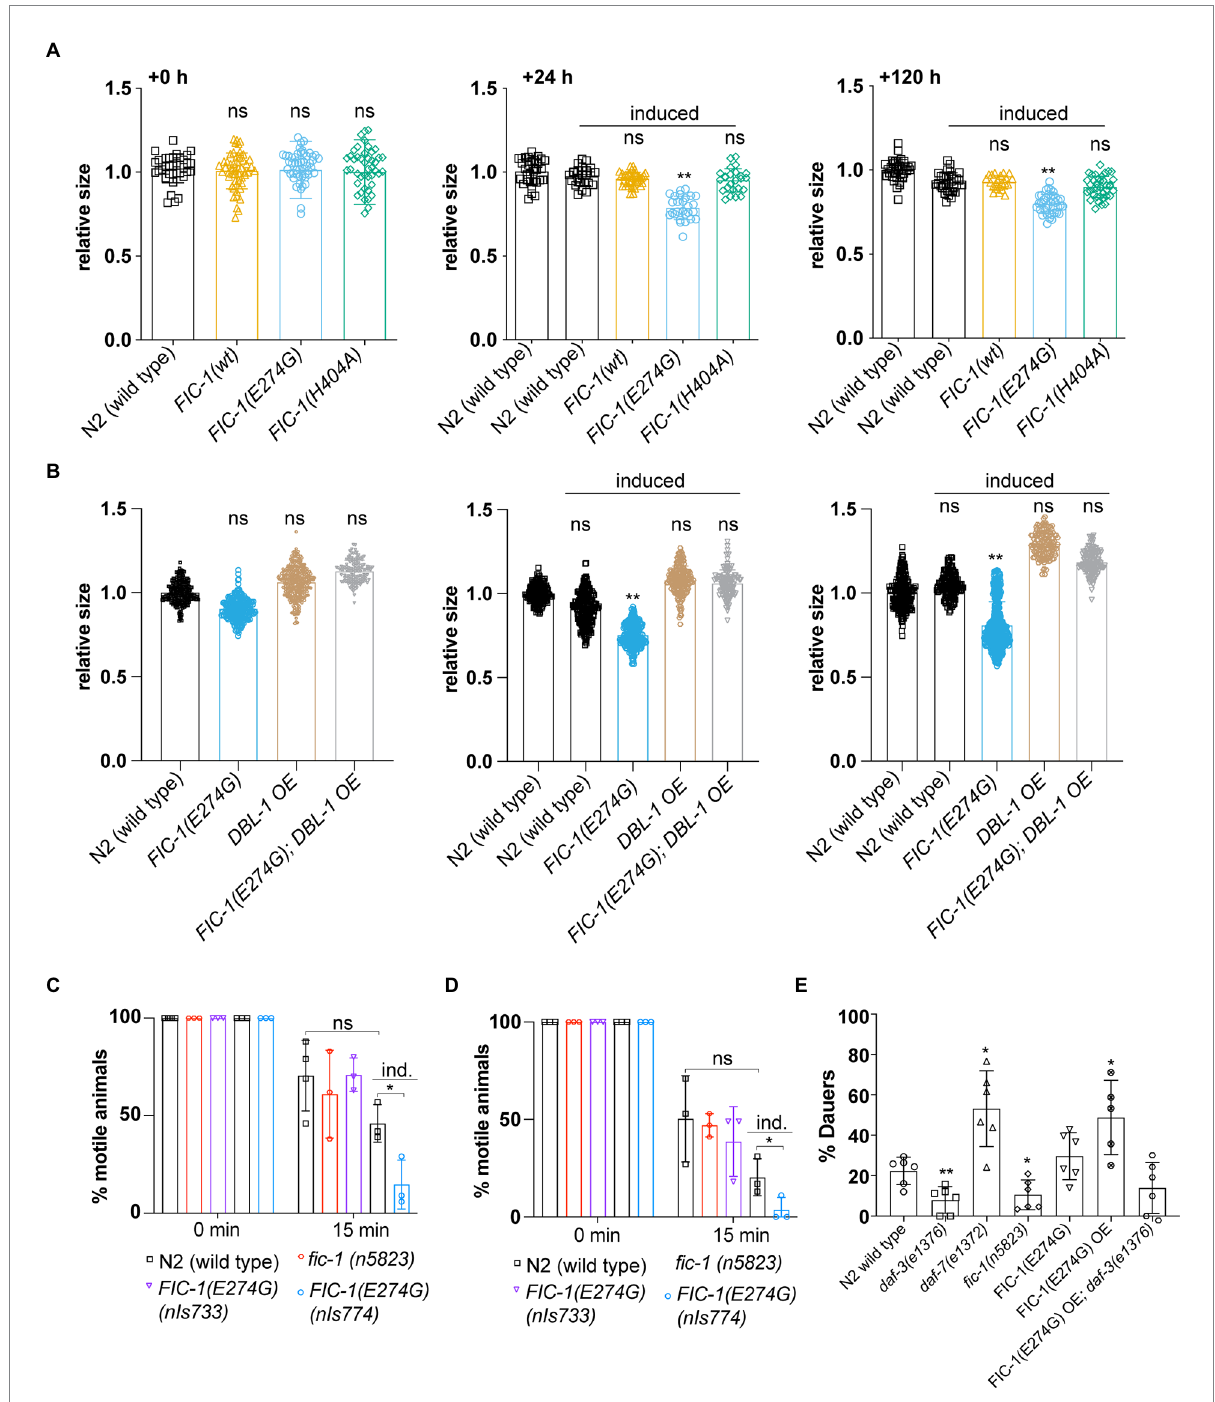
FIGURE 4 FIC-1(E274G)::HA OE interferes with TGF- β signaling-dependent physiological events. (A,B) Relative worm size at indicated timepoints post induction of transgene expression. Worm size was measured using Fiji. Each datapoint represents a single animal. Data was aquired in three biological replicates with >10 animals per replicate. (C,D) Indicated strains were incubated for 15 min in 0.5% (v/v) Nicotine (C) or 2 mM Tetramisole (D) , after which we determined the number of worms that were not paralyzed. Ind: induced (E) Indicated strains were transferred to 27 ° C as L1 larvae to follow dauer entry. For (C–E) : Each datapoint represents a biological replicate with >20 animals per replicate and condition. Error bars represent SD. Statistical significance was calculated using unpaired t -tests. ** p < 0.01, * p < 0.05, not significant (ns) p >